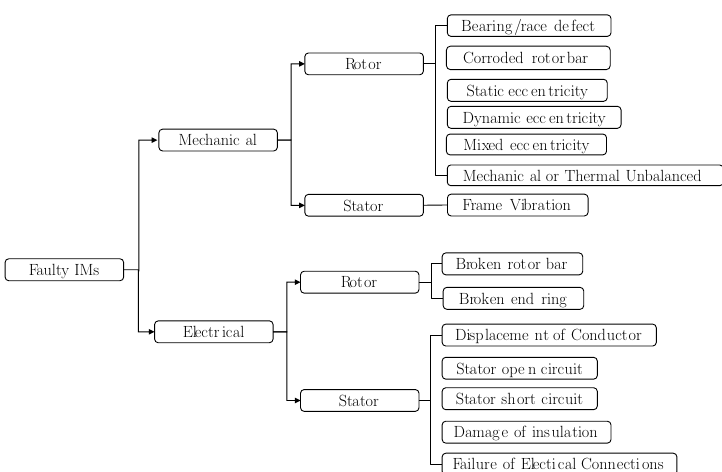
Figure 1. Summary of different types of faults in induction machines [12].